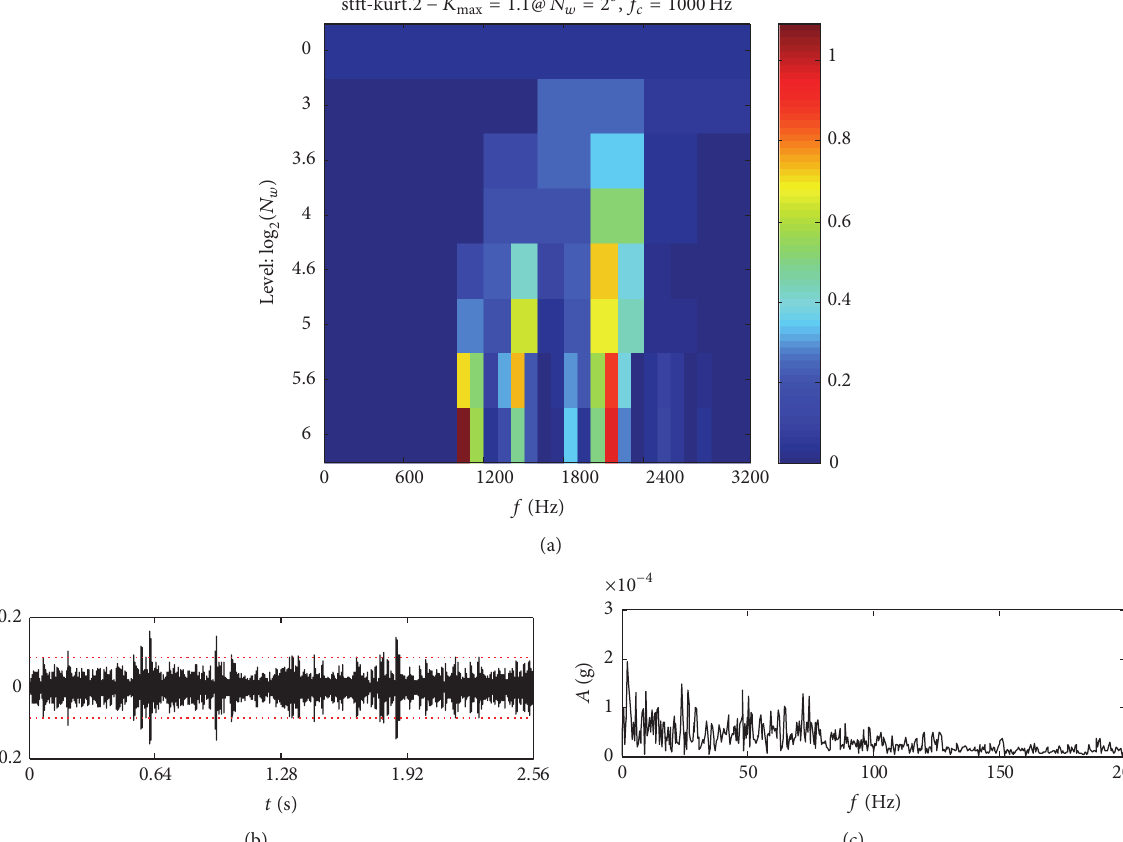
Figure 12: Analyzed results of spectral kurtosis: (a) the Kurtogram; (b) the purified signal; and (c) the envelop spectrum.